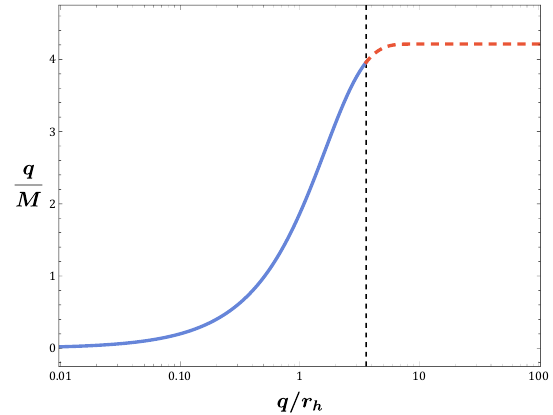
Figure 8. The graph of the ratio q/M in terms of q/r h . Both quantities are dimensionless, while the horizontal axis is logarithmic and the vertical dashed line lies at q/r correspond to black-hole solutions. The blue continuous line represents stable solutions, while the red dashed line refers to unstable